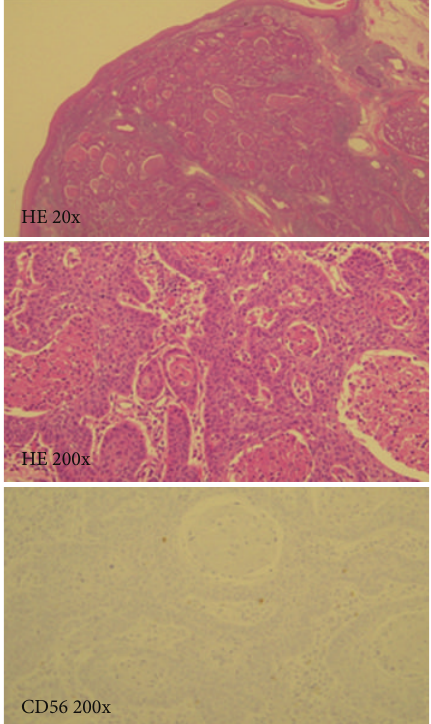
Figure 3: The SCC component of the tumor. The first component was highly differentiated SCC with a cancer pearl. CD56 was not